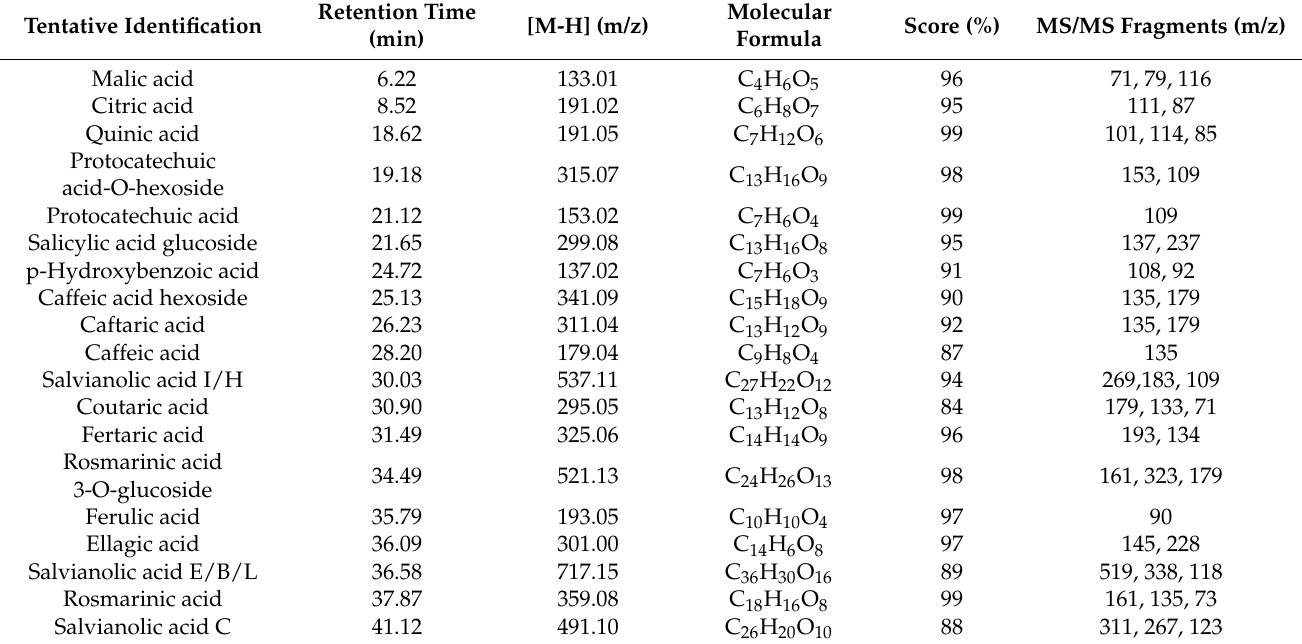
Table 3. Identification of phenolic compounds and others by